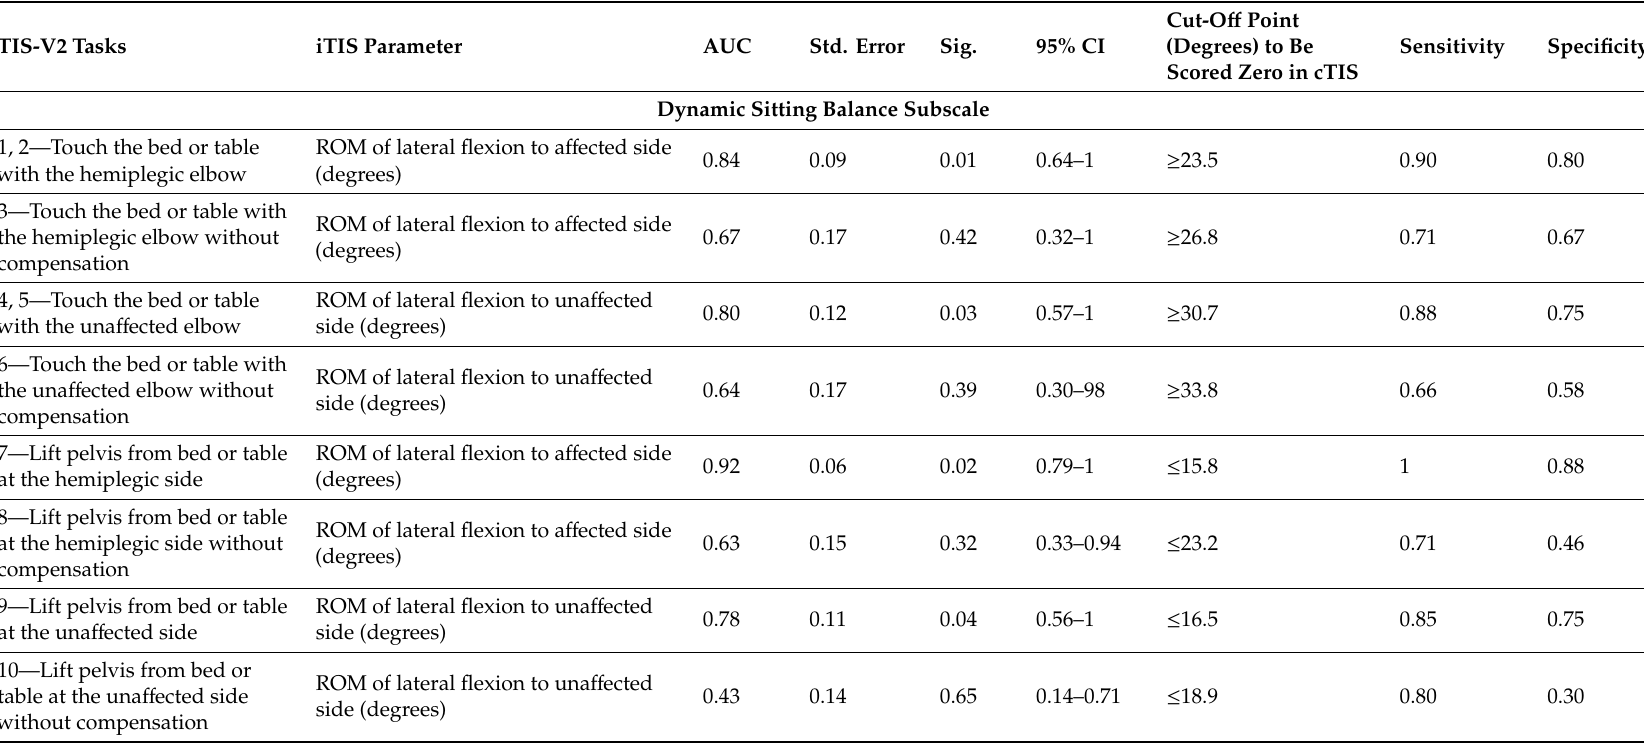
Table 7. Discriminant ability of iTIS parameters in distinguishing between stroke participants with impairment (scored zero on cTIS-V2 tasks) and those without trunk impairment (scored one, or two on cTIS-V2